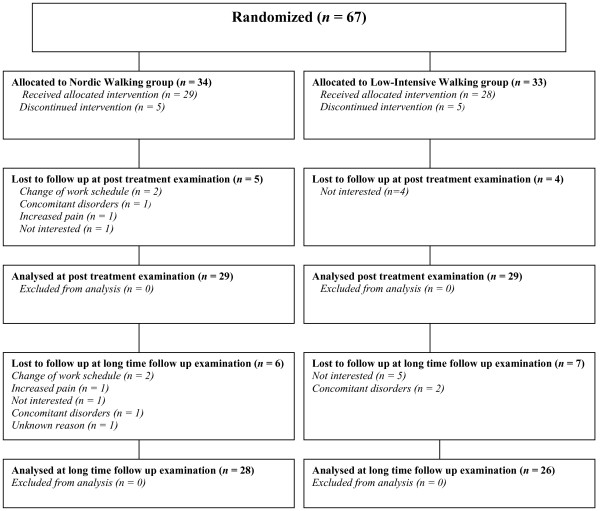
Participants' flow.